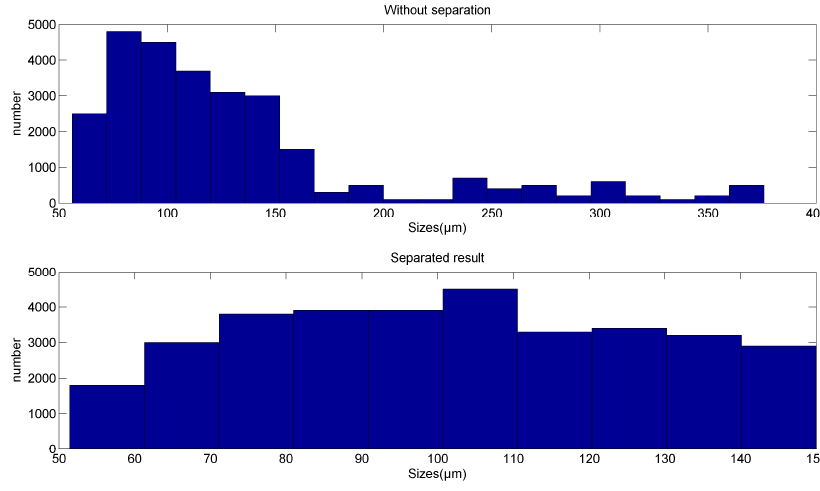
Figure 16. Statistical result of the number of particle.